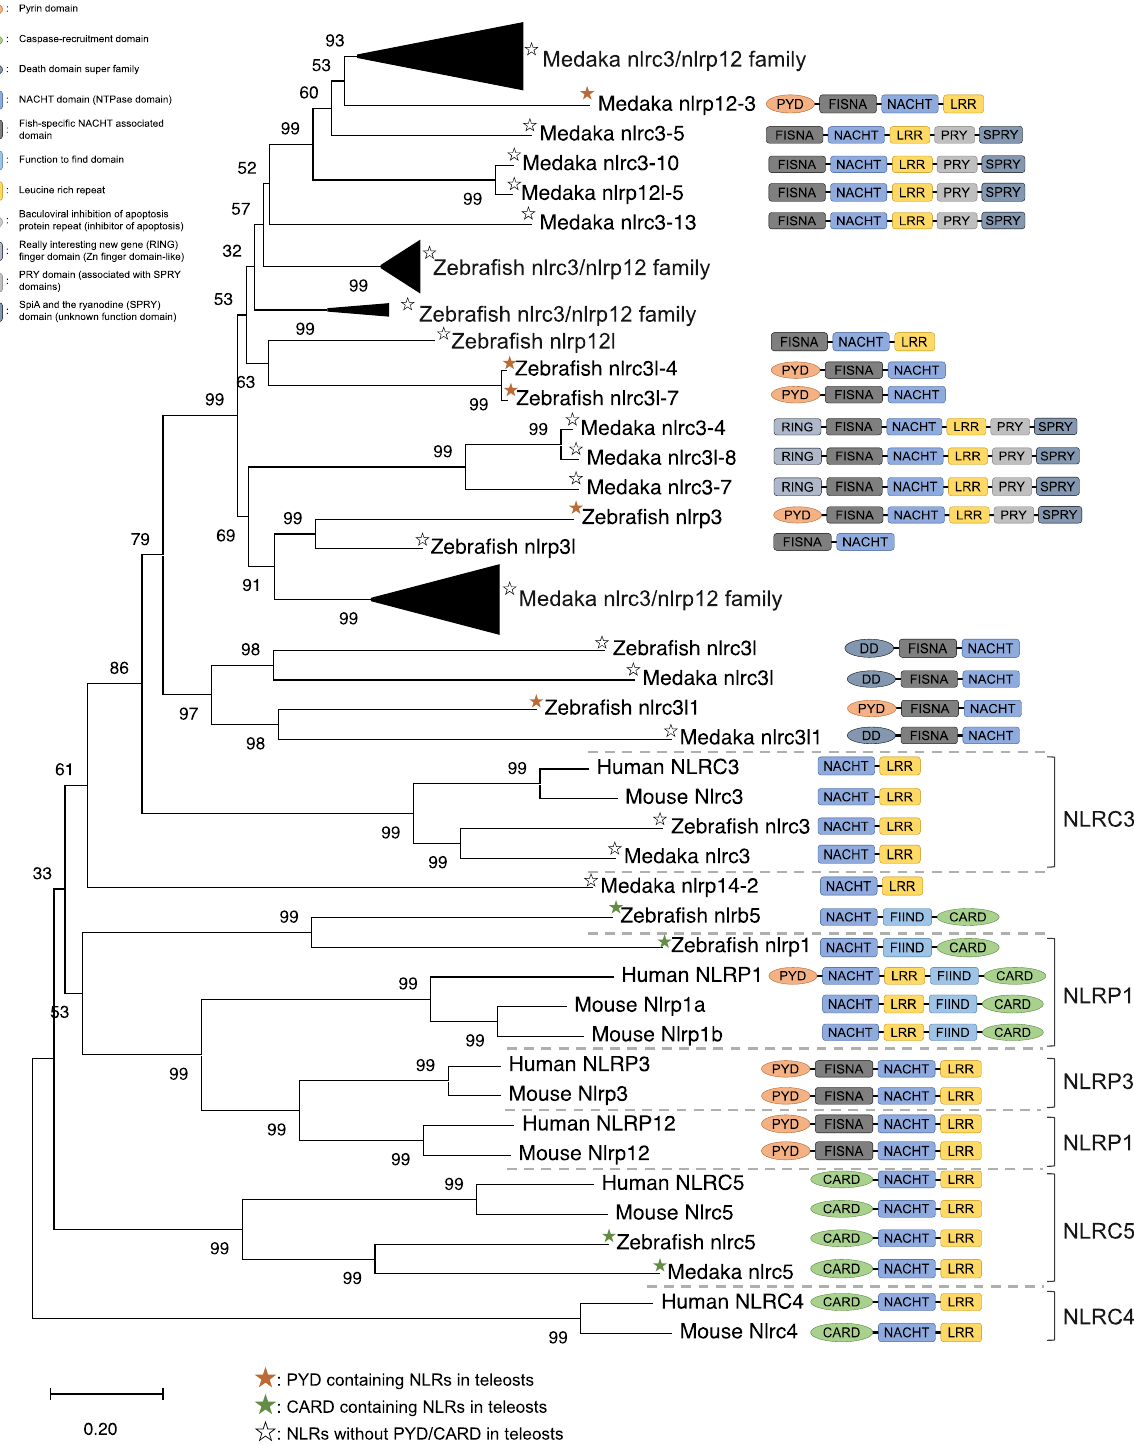
Figure 1. Phylogenetic relationship of the nucleotide-binding oligomerization domain-leucine-rich repeat-containing receptor family in mammals (human and mouse) and fish (Japanese medaka and zebrafish). The tree was constructed using the MEGAX and a neighbor-joining method with 1000 bootstrap replications. The black triangle shapes show collection of the clusters.